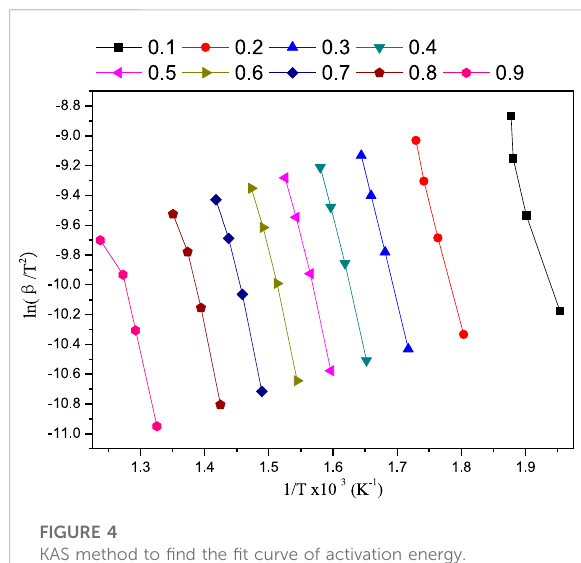
FIGURE 4 KAS method to fi nd the fi t curve of activation